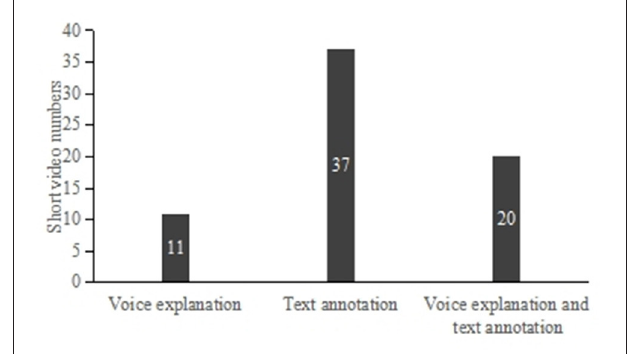
FIGURE 4 | Ways of fitness explanation of short fitness videos on TikTok.